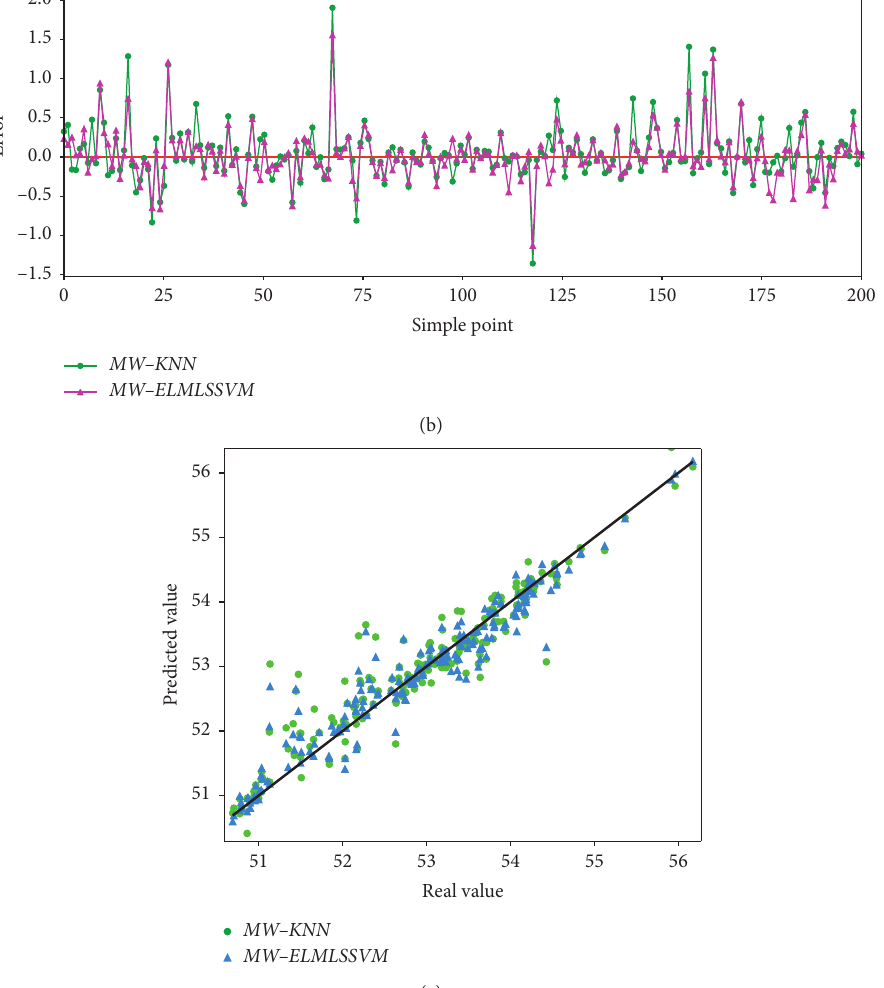
Figure 17: Experimental results under different hybrid